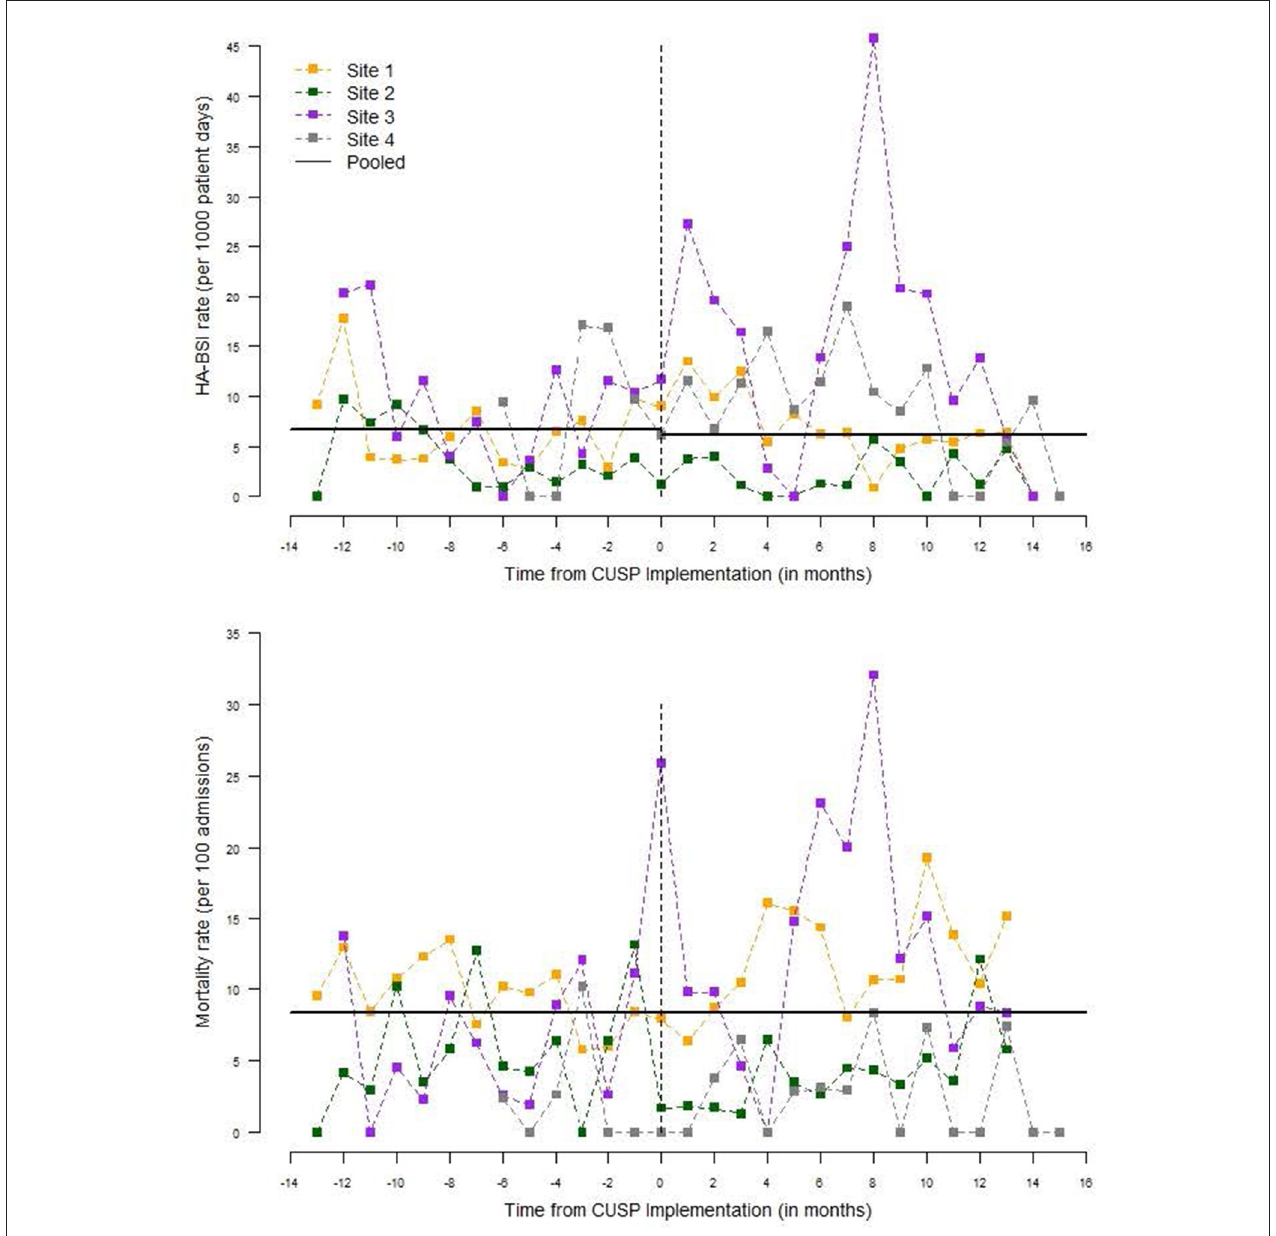
FIGURE 3 | Healthcare-associated bloodstream infection rate and all-cause mortality by site and month. The monthly HA-BSI was expressed as cases per 1,000 patient-days. All-cause mortality was expressed as deaths per 100 admissions among neonates admitted for at least 3 days. The pooled estimates are based on a Poisson regression model for the monthly rate of HA-BSI or mortality as a function of post- vs. pre-CUSP implementation. CUSP, Comprehensive Unit-based Safety Program; HA-BSI, healthcare-associated bloodstream infection.